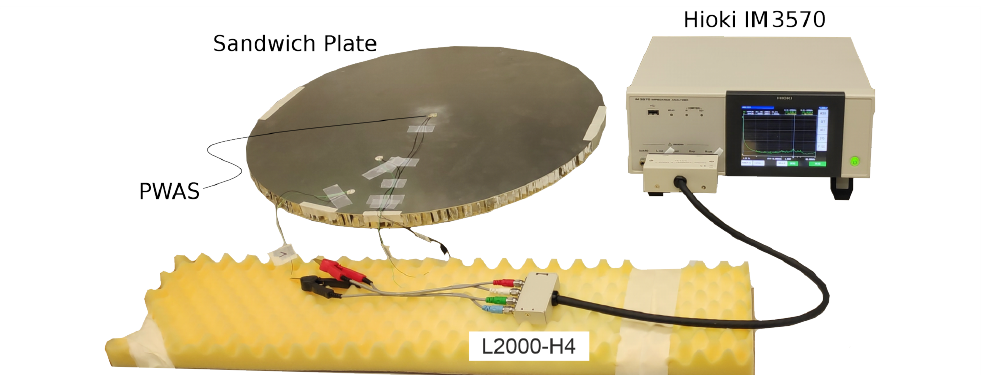
Figure 4. Setup for real-world EMI measurements.